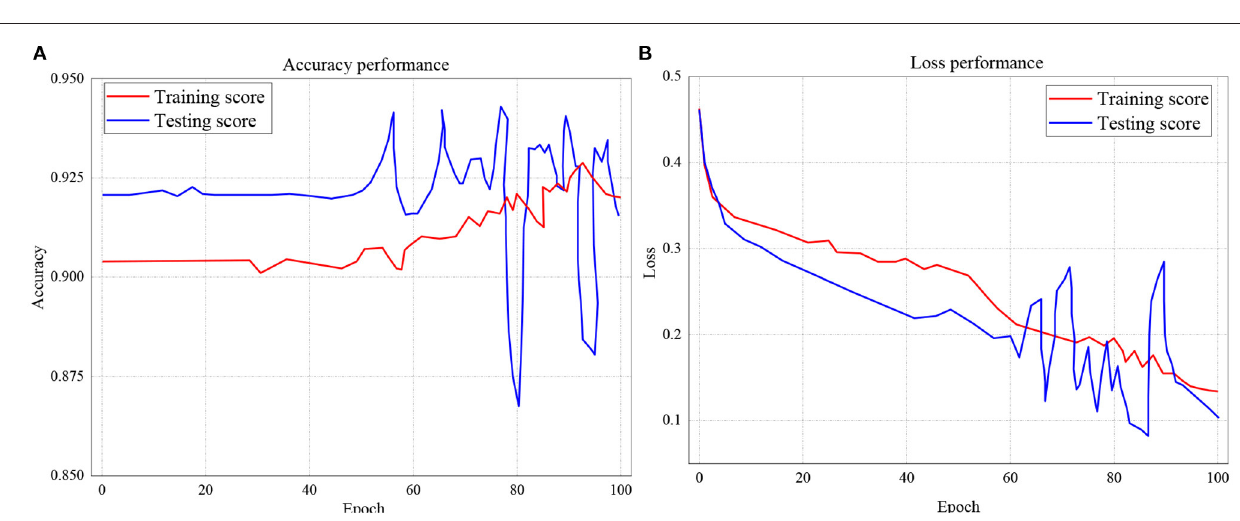
FIGURE 10 | (A,B) Performance accuracy and loss of Training and Testing Scores for